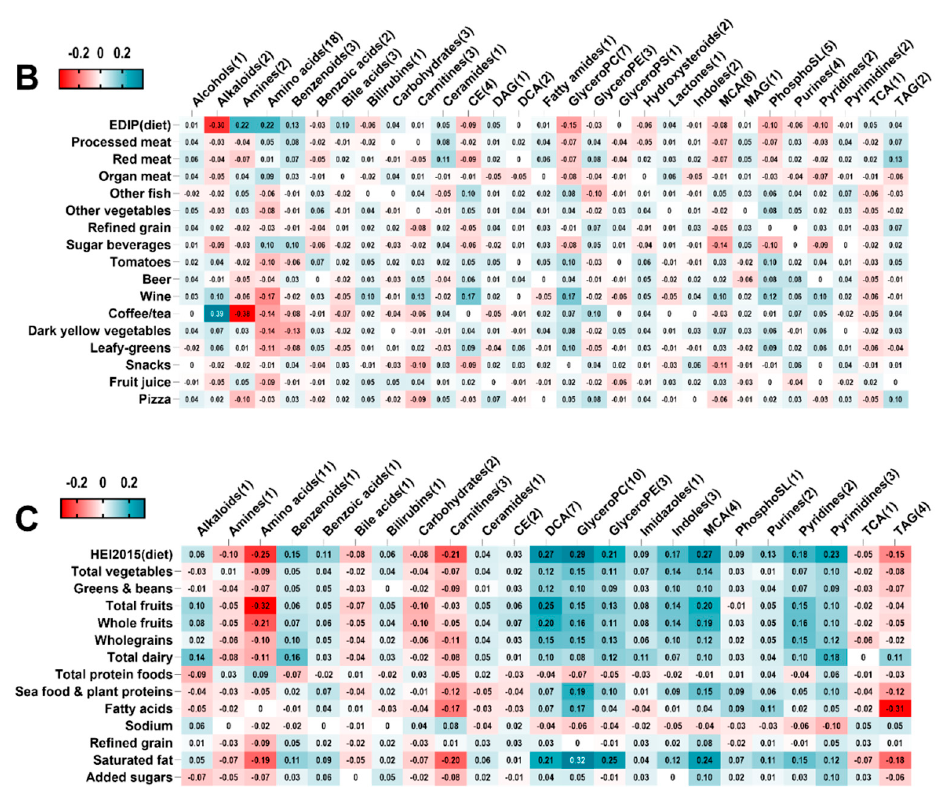
Figure 1. Correlations between dietary pattern food group components and metabolomics class scores. ( A ) Correlations between EDIH food group components and EDIH metabolomic class scores. ( B ), Cor- relations between EDIP food group components and EDIP metabolomic class scores. ( C ), Correlations between HEI-2015 food group components and HEI-2015 metabolomics class scores. Values are par- tial Spearman correlation coefficients adjusted for BMI, physical activity and pack years of